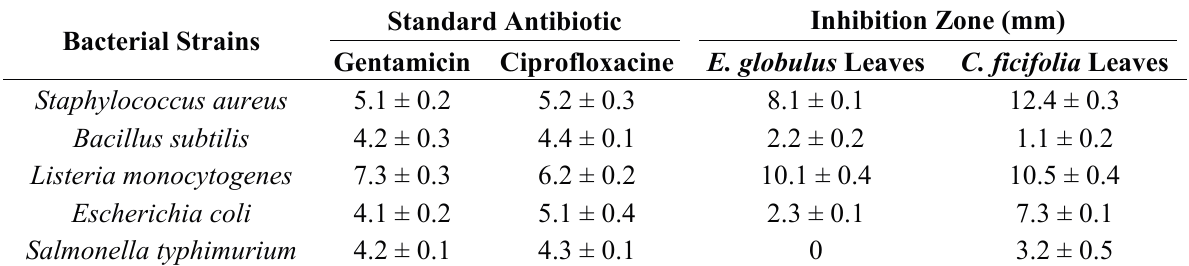
Table 4. Antibacterial activity of E. globulus and C. ficifolia extracts and antibiotic against bacterial species tested by disc diffusion